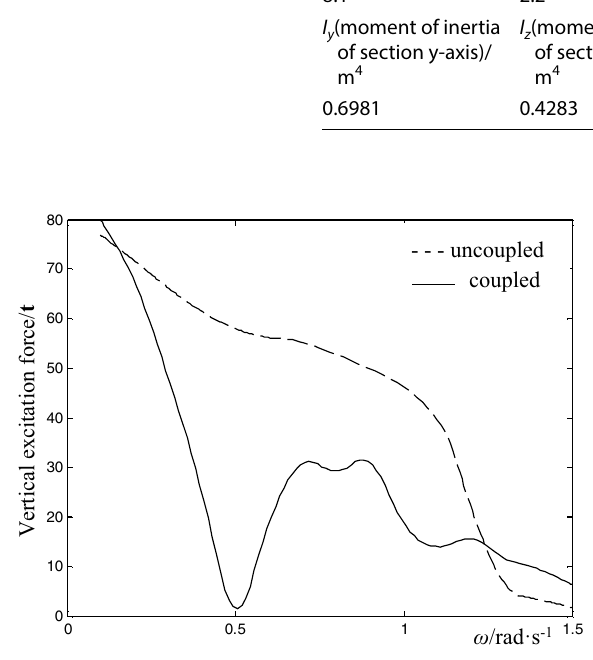
Fig. 9 Influence of wave frequency on the vertical force for the fifth pontoon ( 𝛽 = 45 ◦